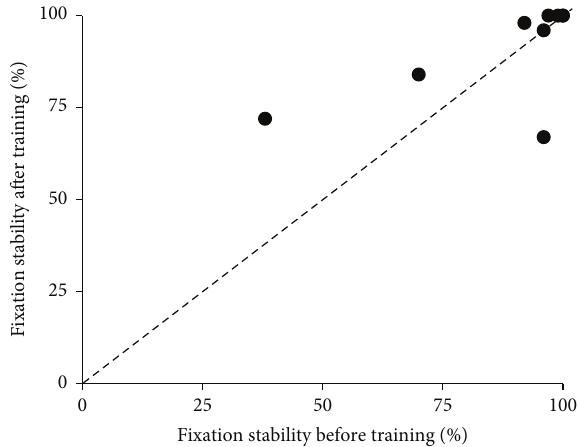
Figure 3: Scatter plot of best corrected visual acuity (BCVA) before and after MAIA biofeedback training.